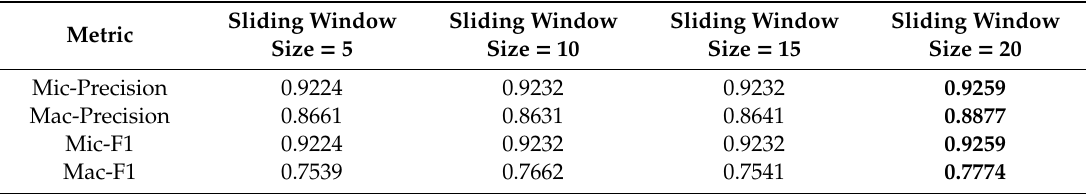
Table 5. Precision and F1 score in different sliding window sizes for 200-dimension word embedding.